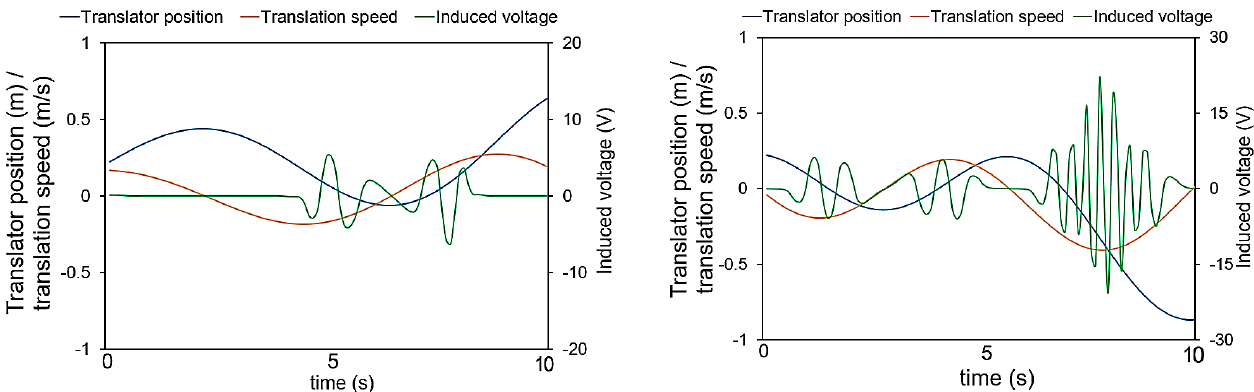
Figure 18. The graph of the induced voltage of the iron-cored LPMG under random wave with equal peak frequency, different significant wave heights of 1.5 m ( left ) and 4.5 m ( right ).